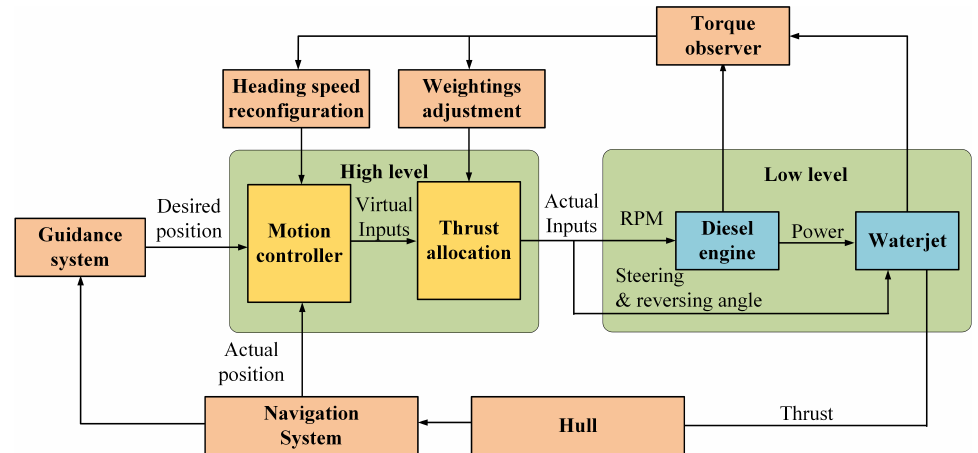
Figure 2. Overall control system structure of the twin-waterjet vessel.